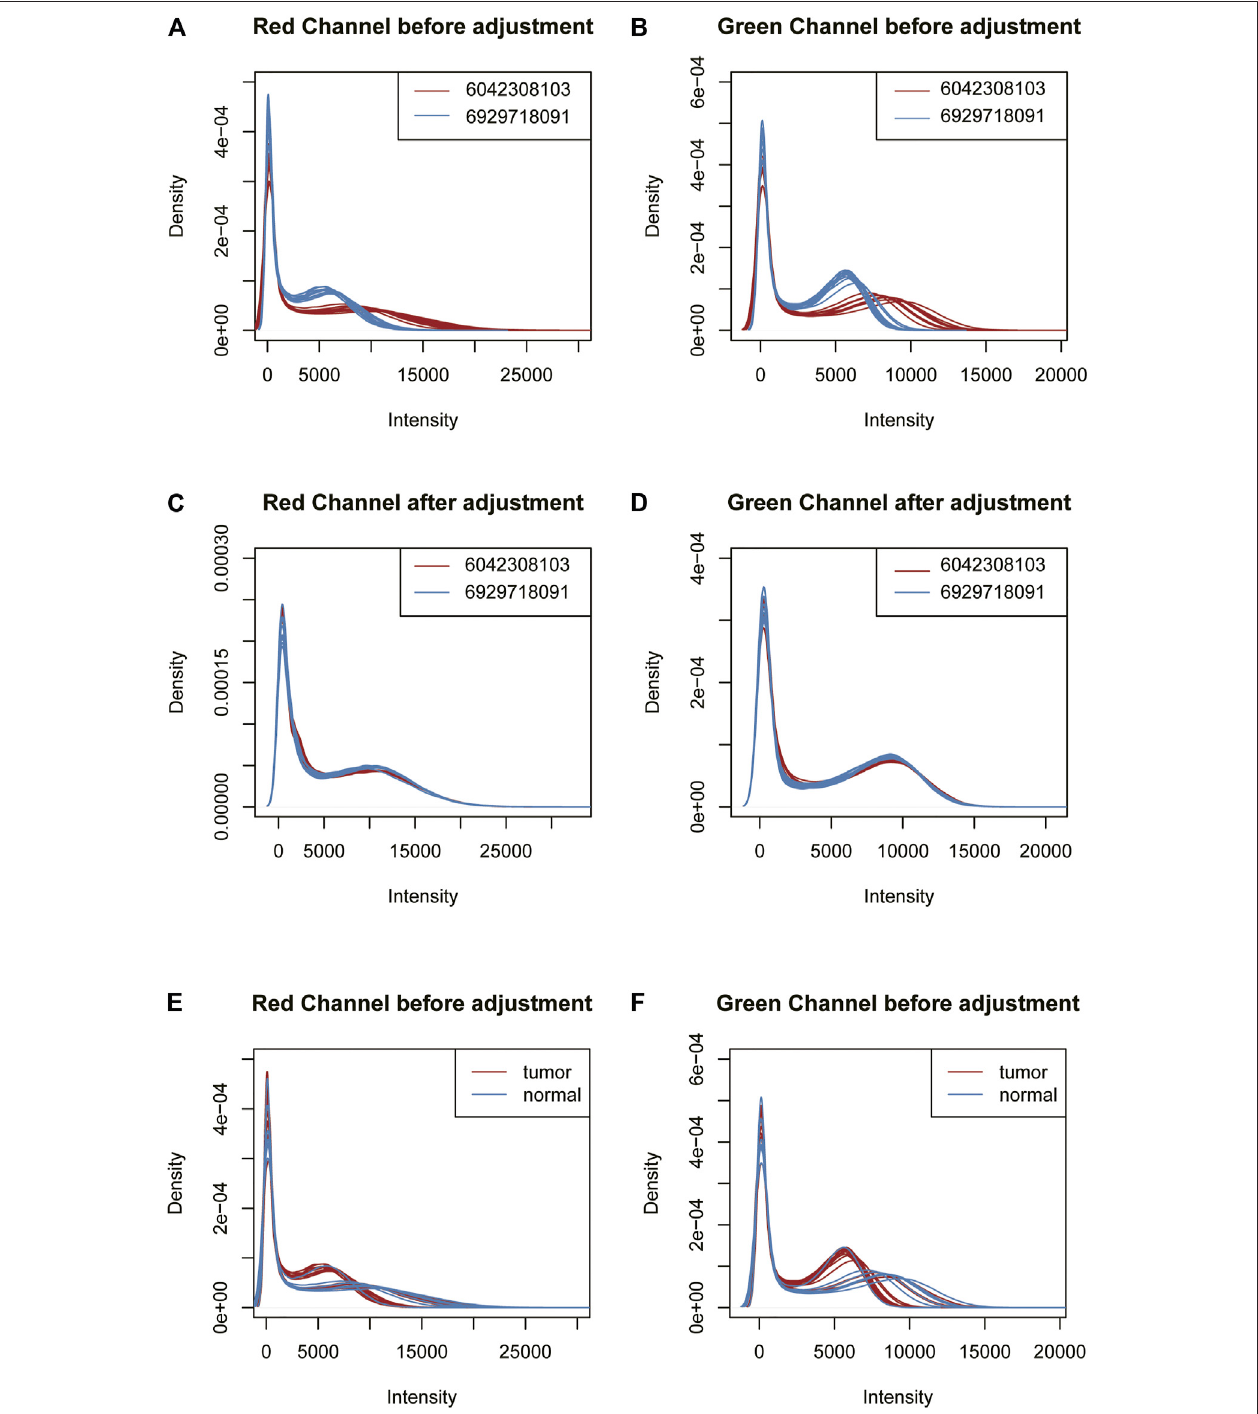
FIGURE 3 | The 450 k data signal strength distribution of the red and green channels of In fi nium I probes before and after GMQN normalization. The signal intensities of the red (A) and green (B) channels of the two batches were clearly divided into two batches before being corrected. And the differences Were not due to biological differences (tumor and normal) (E,F) . After the GMQN correction, the batch effect problem is signi fi cantly reduced (C,D) .